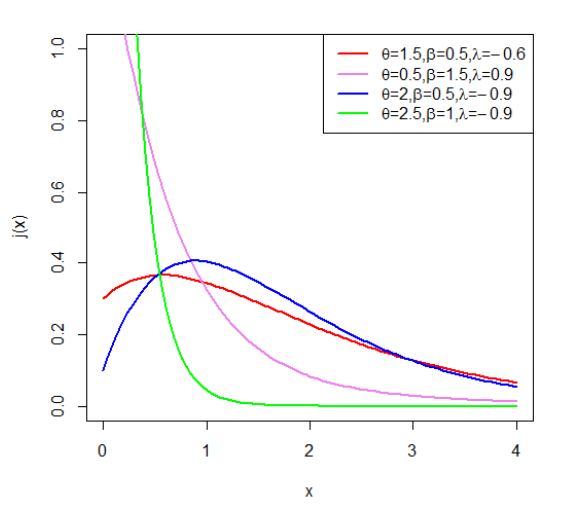
Figure 1 – Pdf of ET E distribution for various choices of α , θ and λ